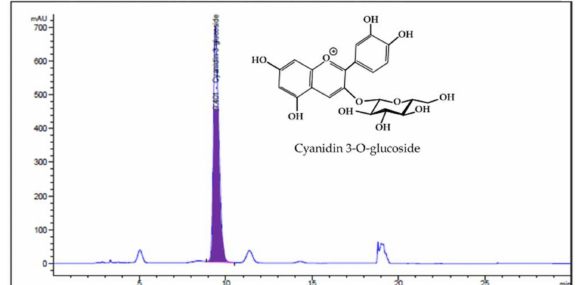
Figure 1. High-Performance Liquid Chromatography with Diode Array Detection (HPLC-DAD) chromatogram of main component in honeyberry ( Lonicera caerulea ). HPLC-DAD traces at 517 nm, Cyanidin 3-O-glucoside (C3G), was detected at 5.91 mg/mL in 25% ethanolic extract of honeyberry using high-performance liquid chromatography (HPLC)